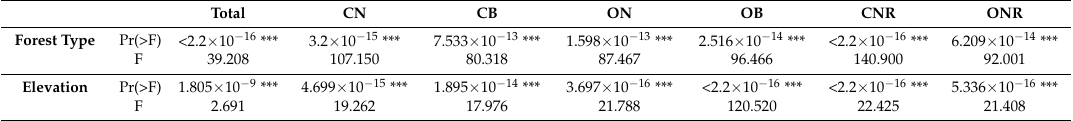
Table 4. Results of multivariate ANOVA showing the effects of forest type and elevation on growth properties.